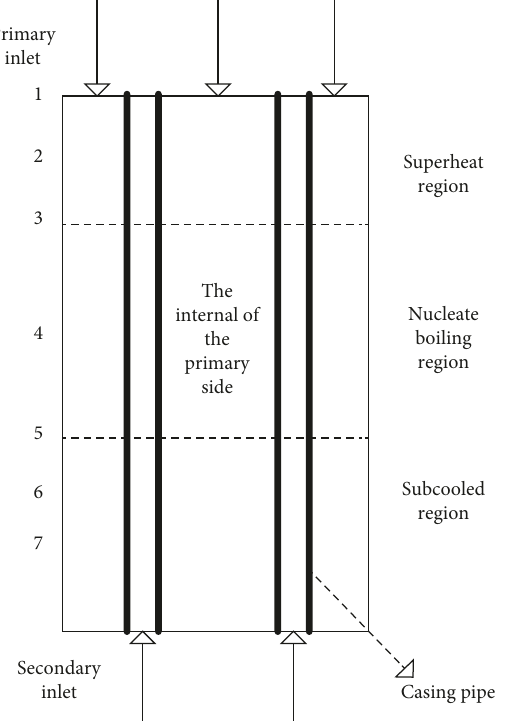
Figure 1: The schematic diagram of